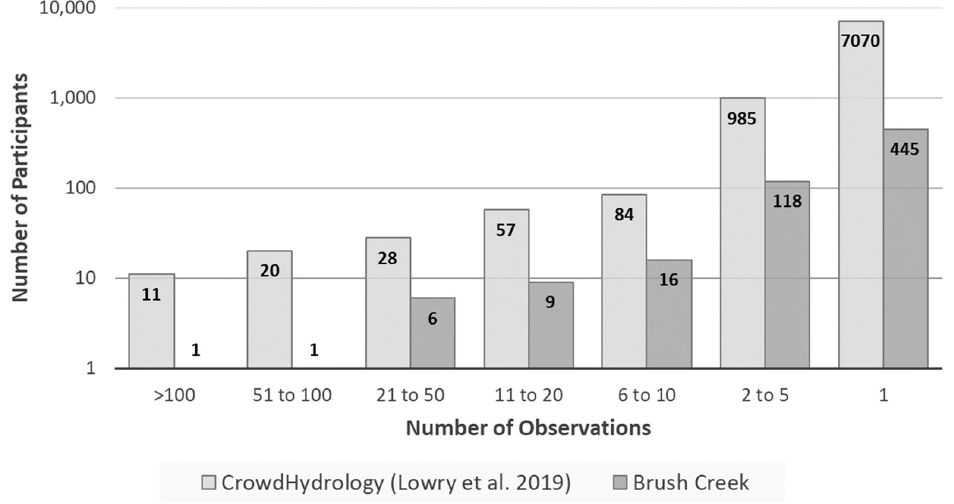
Figure 9. Distribution of frequency of observations by individual participant for current research (Brush Creek) compared to findings of Lowry et al. (2019).